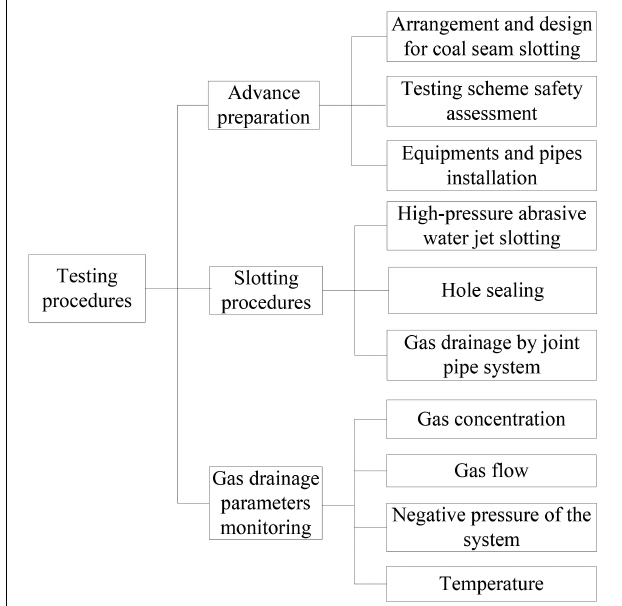
FIGURE 5 | Experimental procedures.